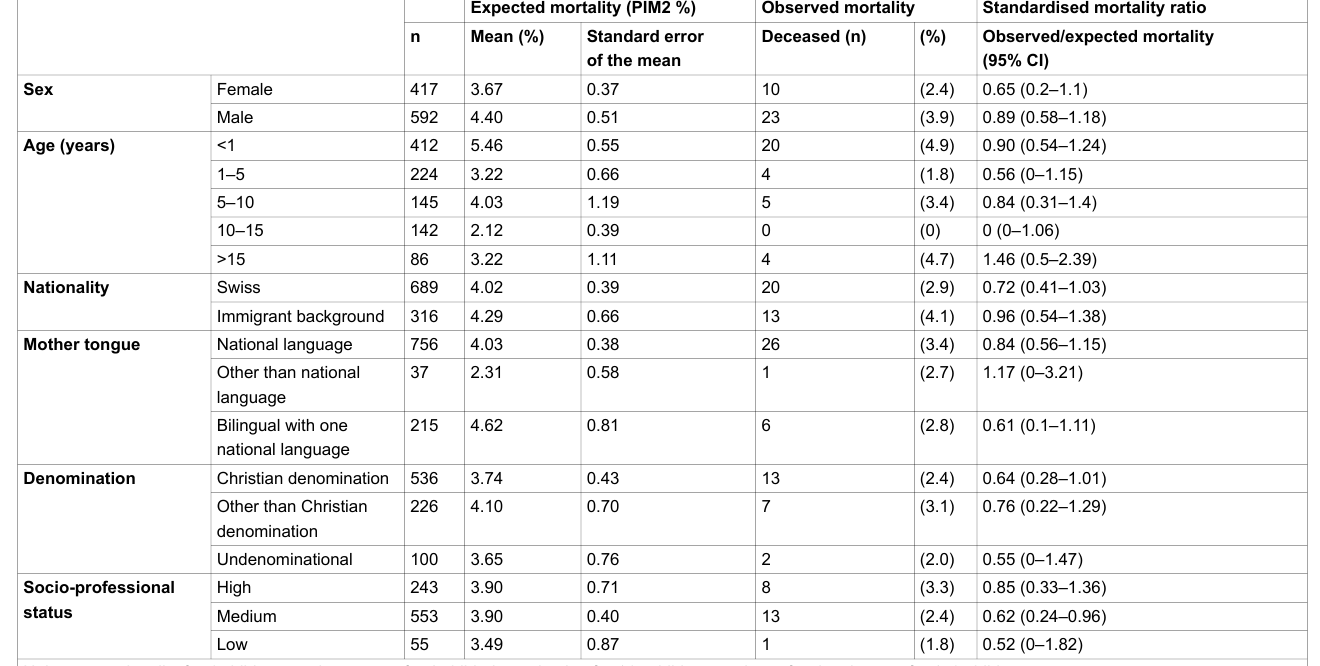
Unknown: nationality for 4 children, mother tongue for 1 child, denomination for 147 children, socio-professional status for 158